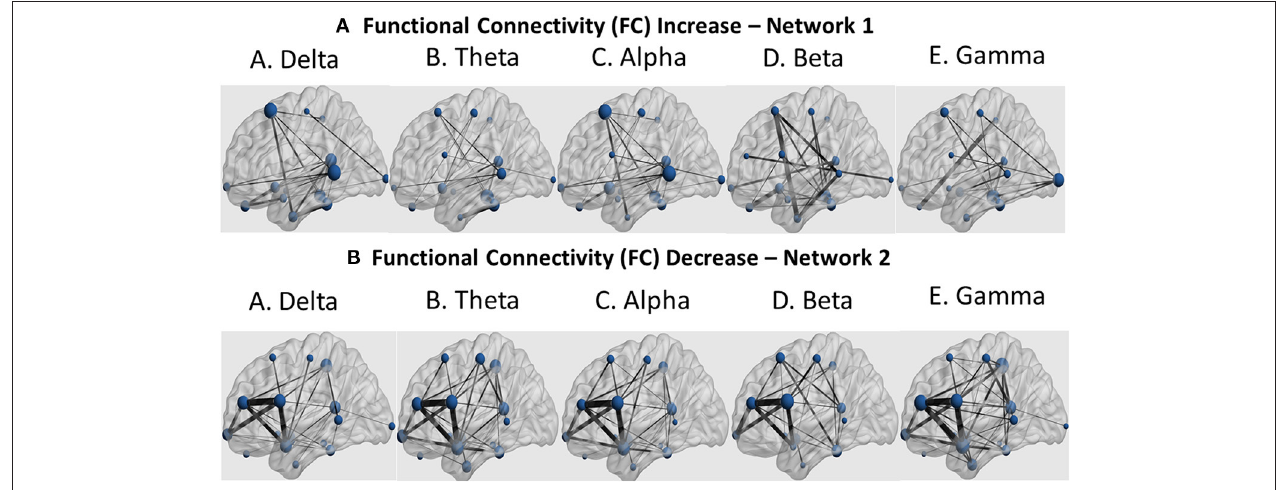
FIGURE 7 | Sagittal view of the two subnetworks showing either a functional connectivity linear increase (A) or decrease pattern (B) across the three experimental stages (baseline, 1st and 2nd training periods) for the five cortical rhythms (delta, theta, alpha, beta and gamma) among the cortical regions identified by the cortical oscillatory analysis. The node size is proportional to its degree, whereas the edge width is proportional to the connectivity magnitude.